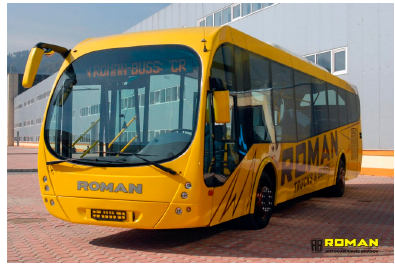
Figure 5. Urban Crosstown Bus.